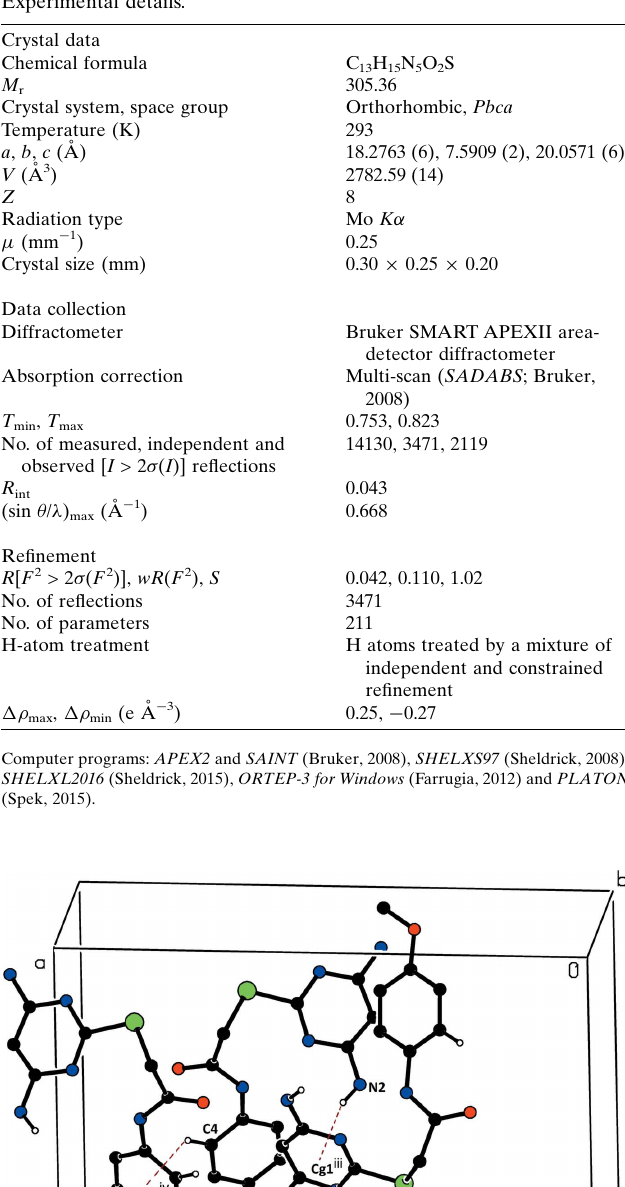
, y , (cid:4) z + 1 .] 2 2